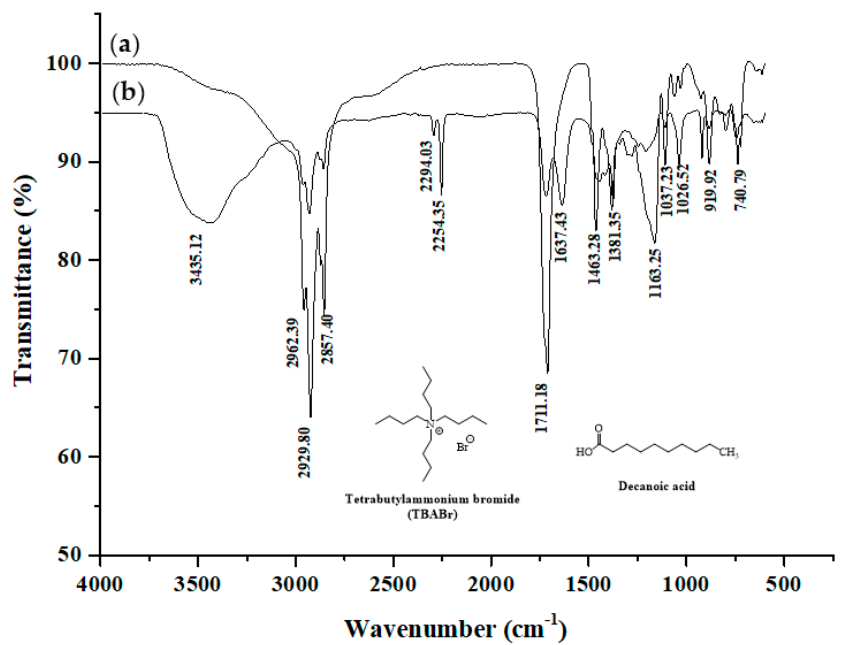
Figure 1. The Fourier transform infrared (FTIR) spectra of ( a ) hydrophobic deep eutectic solvents (DESs) and DES with acetonitrile (ACN) and ( b ) sodium dodecyl sulfate (SDS).